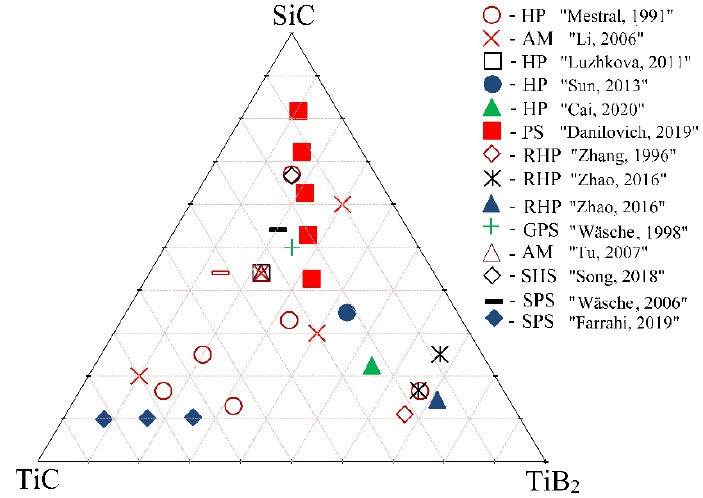
Figure 1. Phase diagram of the SiC-TiB 2 -TiC system (mol%) indicating the studied compositions in previous works [5,9,44–55].